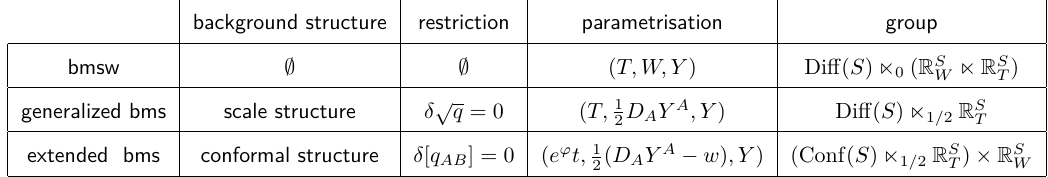
Table 3 . Comparison of the extended, generalized BMS and BMSW group structure and parametri- sation. The notation n α denotes the action of diffeomorphims on densities of weight α . R S to super-translations and R W to Weyl